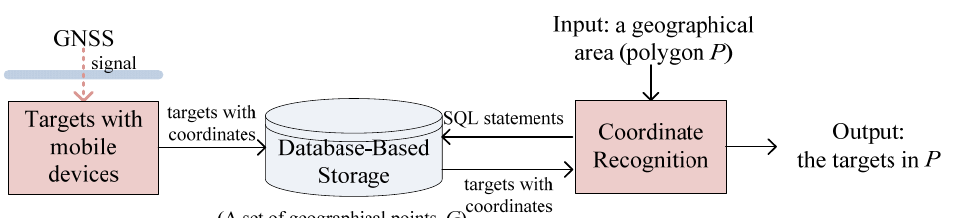
Figure 1. System architecture. Each target has a mobile device with a GNSS receiver. The mobile device can receive GNSS signals, convert them into coordinate data, and send the data to database-based storage. A computer performs the operation of coordinate recognition with the input of a geographical area P and can obtain the targets in the area P .